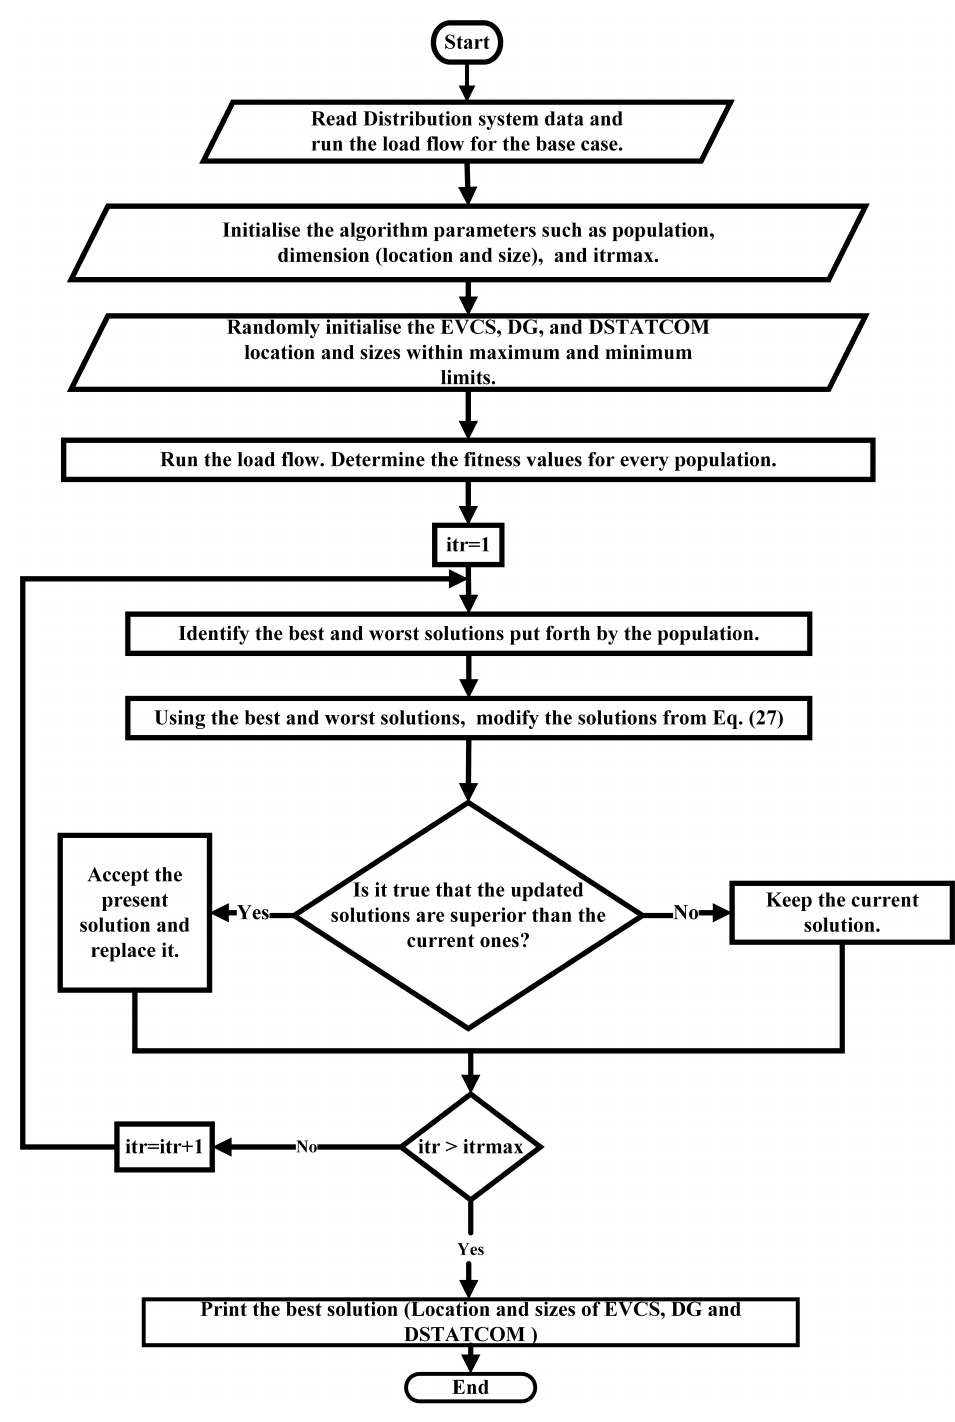
Figure 8. RAO-3 algorithm implementation flow